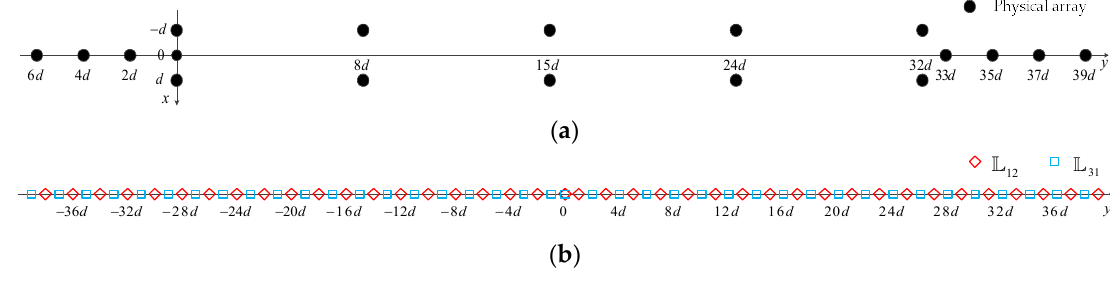
Figure 3. An example of TPNAs-II, where N 1 = 8, N 2 = 5. ( a ) physical array; ( b ) the corresponding difference coarray consisting of L 12 and L 31